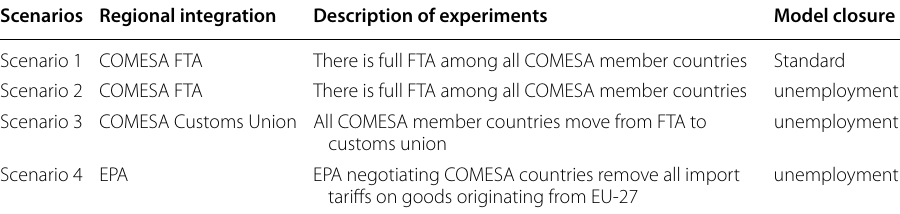
Table 5 Experiment design. Source: Authors experiment